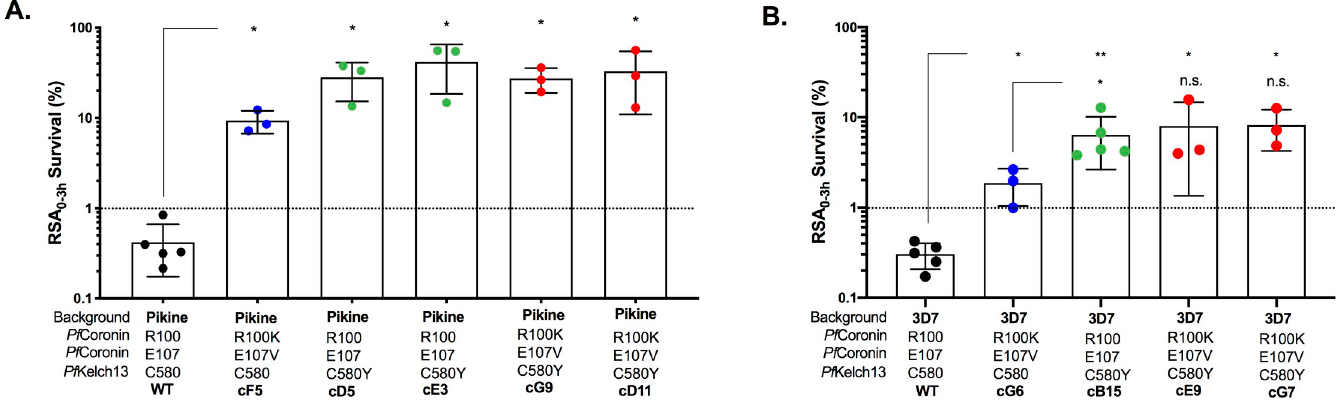
Fig 4. The contributions of pfcoronin and pfkelch13 to resistance are non-additive. A. Ring-stage survival assay (RSA) survival percentage for one clone of pfcoronin single mutant (cF5 published previously [17], blue), two clones of pfkelch13 single mutants (cD5 and cE3, green) and two clones of pfcoronin and pfkelch13 double mutants (cG9 and cD11, red) in the Pikine background compared to the wildtype (WT, black). B. Ring-stage survival assay (RSA) survival percentage for one clone of pfcoronin single mutant (cG6, blue), one clone of pfkelch13 single mutant (cB15, green) and two clones of pfcoronin and pfkelch13 double mutants (cE9 and cG7, red) in the 3D7 genetic background compared to the wildtype (WT, black). Each point represents an independent biological replicate and dotted line represents the 1% survival threshold, above which survival is considered resistant. Significance level is indicated by the asterisks, � p < 005, �� p < 0.01, determined using two-tailed Mann-Whitney U test.